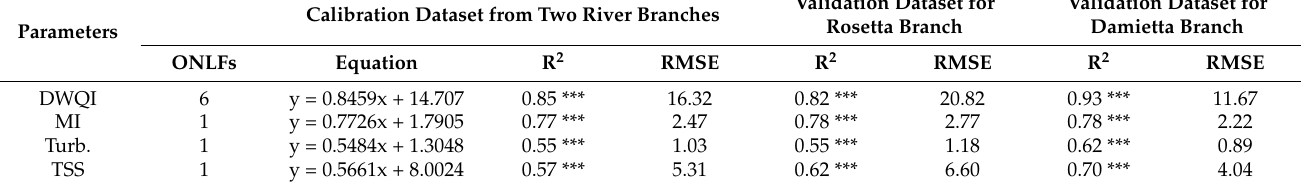
Table 8. Calibration and validation models between the observed and predicted values (R 2 and RMSE) based on PLSR. These models were calibrated using a dataset for two Nile River branches. Following that, the calibration equations for various models were used to predict drinking water quality index (DWQI), metal index (MI), turbidity (Turb.) and total suspended solids (TSS) for each branch.